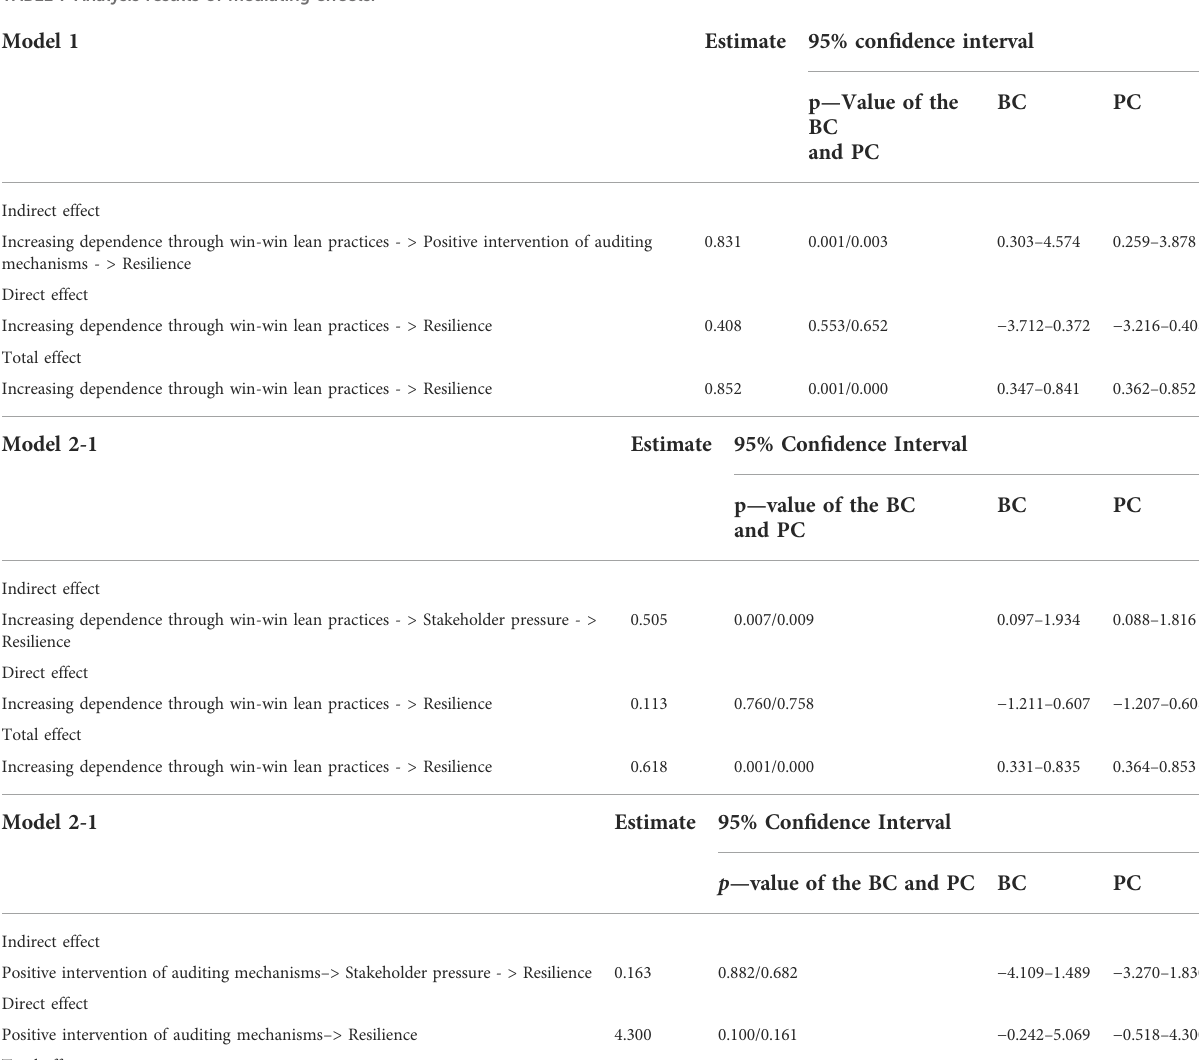
TABLE 7 Analysis results of mediating